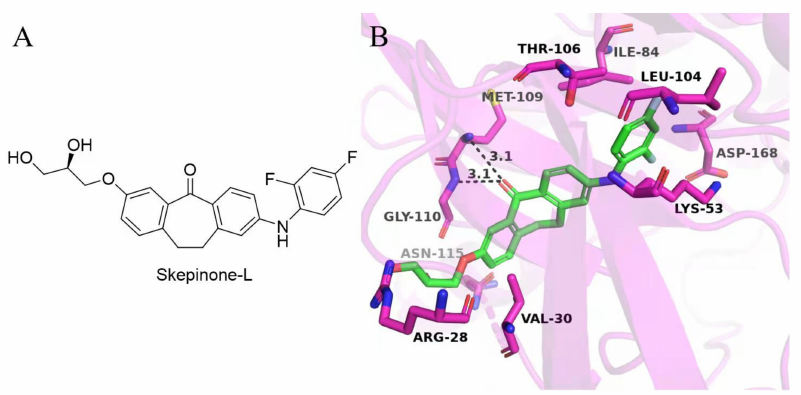
Figure 2. ( A ) The chemical structure of skepinone-L; ( B ) Predicted binding mode of skepinone-L with MAPK11. The structure of MAPK11 is shown in red cartoon (PDB ID: 3GC8). Skepinone-L is presented as green sticks. Key residues are shown in purple sticks and labeled. The H-bond interactions are depicted as black dashed lines.